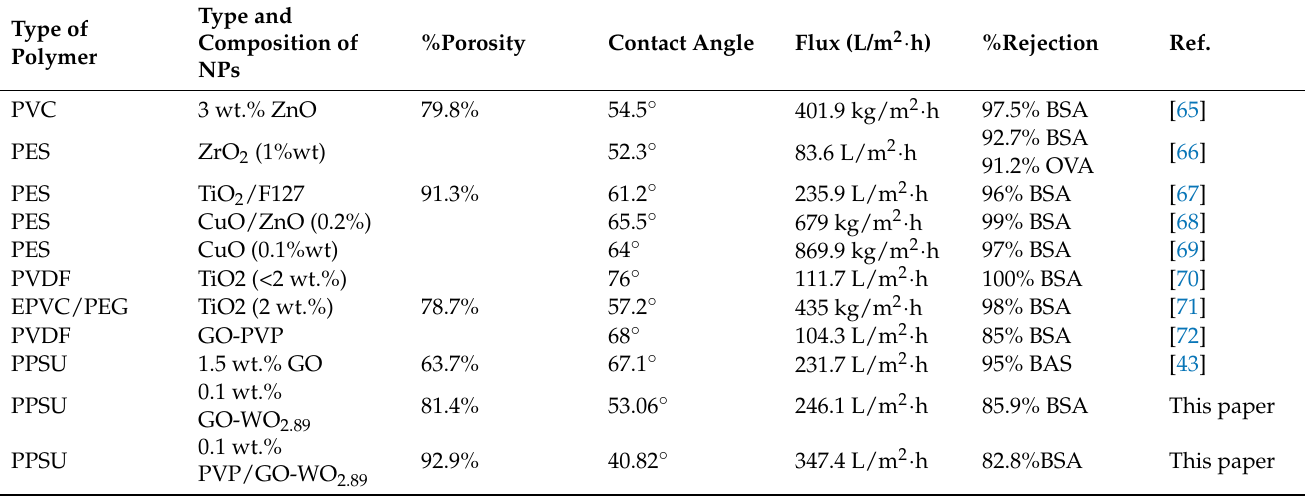
Table 5. Demonstrates the comparison of this work with recently published